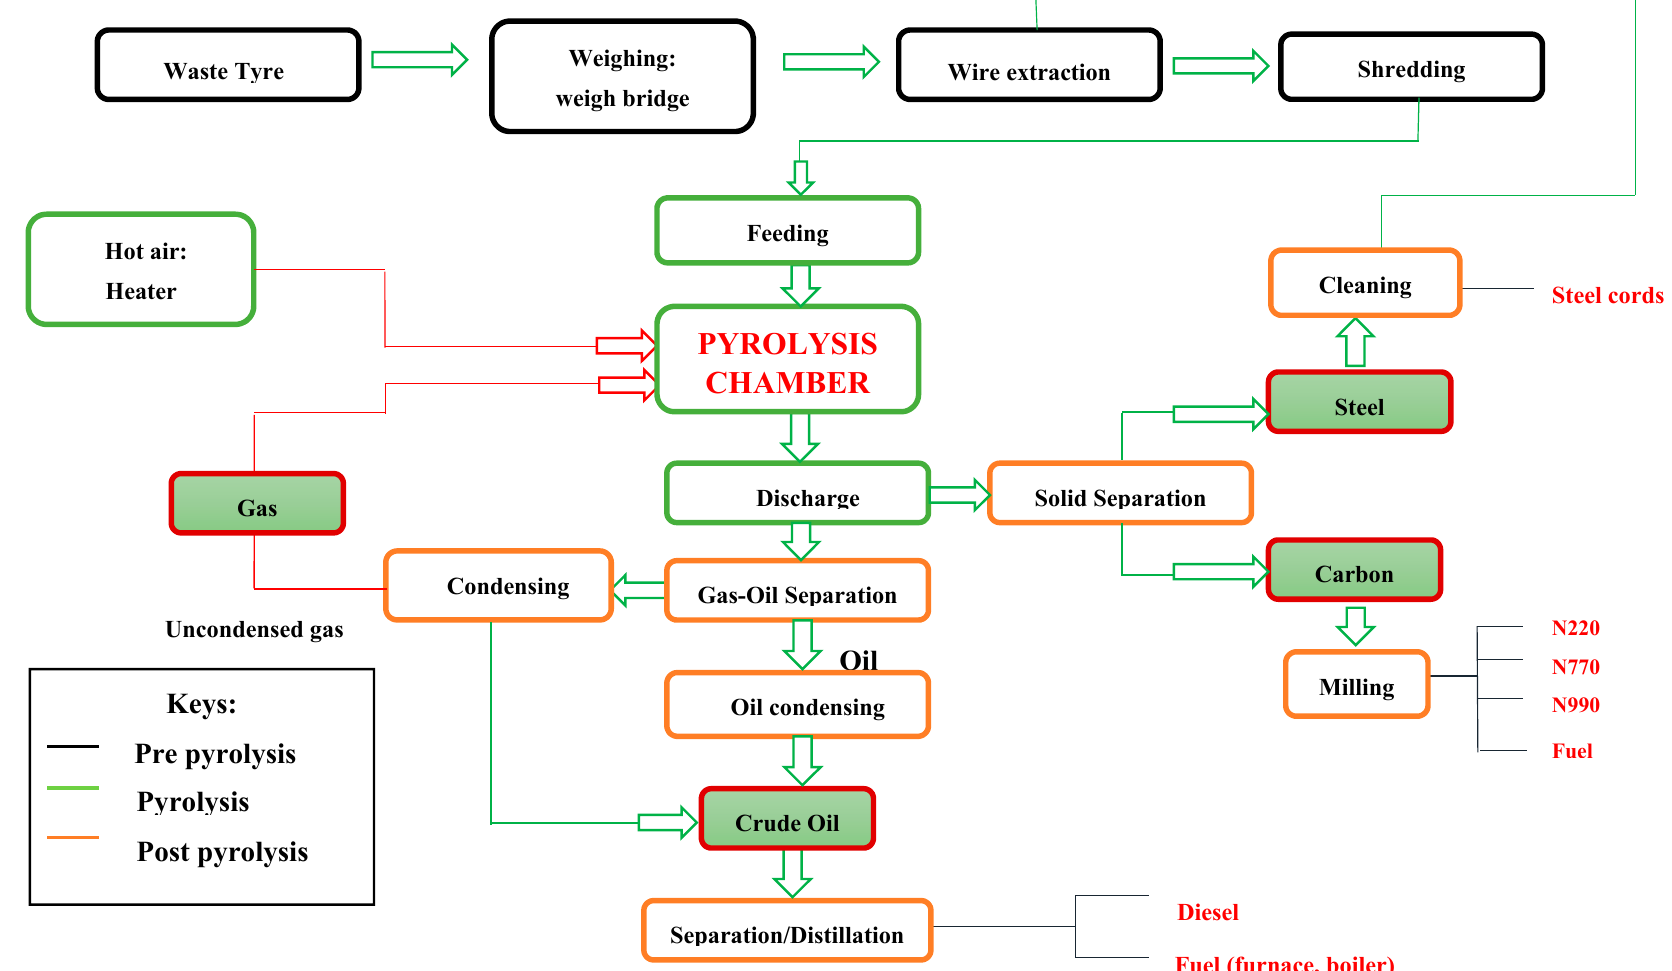
Figure 1. Process flow diagram.